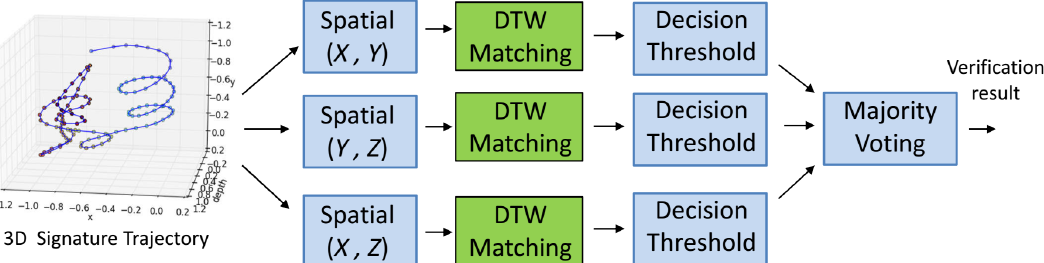
Figure 8. Our framework for an improved 2D spatial-based signature verification ( ISSV )